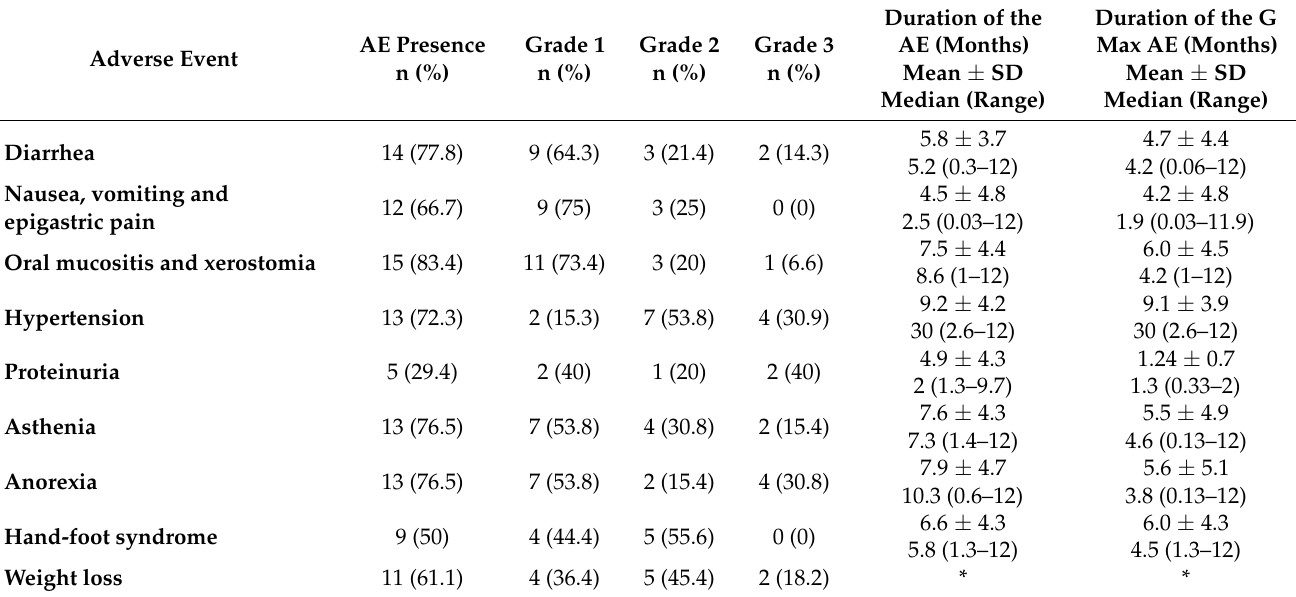
Table 2. Prevalence, grade and duration of the adverse events.